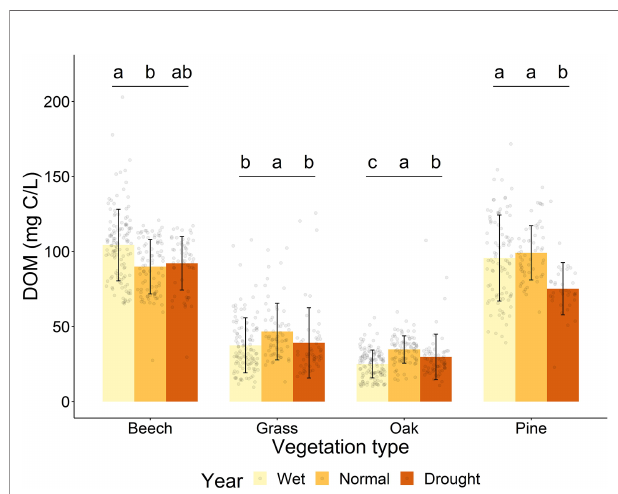
FIGURE 4 | DOM concentration at 5 and 10 cm depth of different vegetation types. Letters show statistically signi fi cant differences in DOM concentration within vegetation types. Signi fi cant differences were determined by linear mixed models and Tukey-adjusted p-values for estimated marginal means (p < 0.05). Outlier calculation was not performed as there is temporal variation within each group which could be wrongly interpreted as outliers.